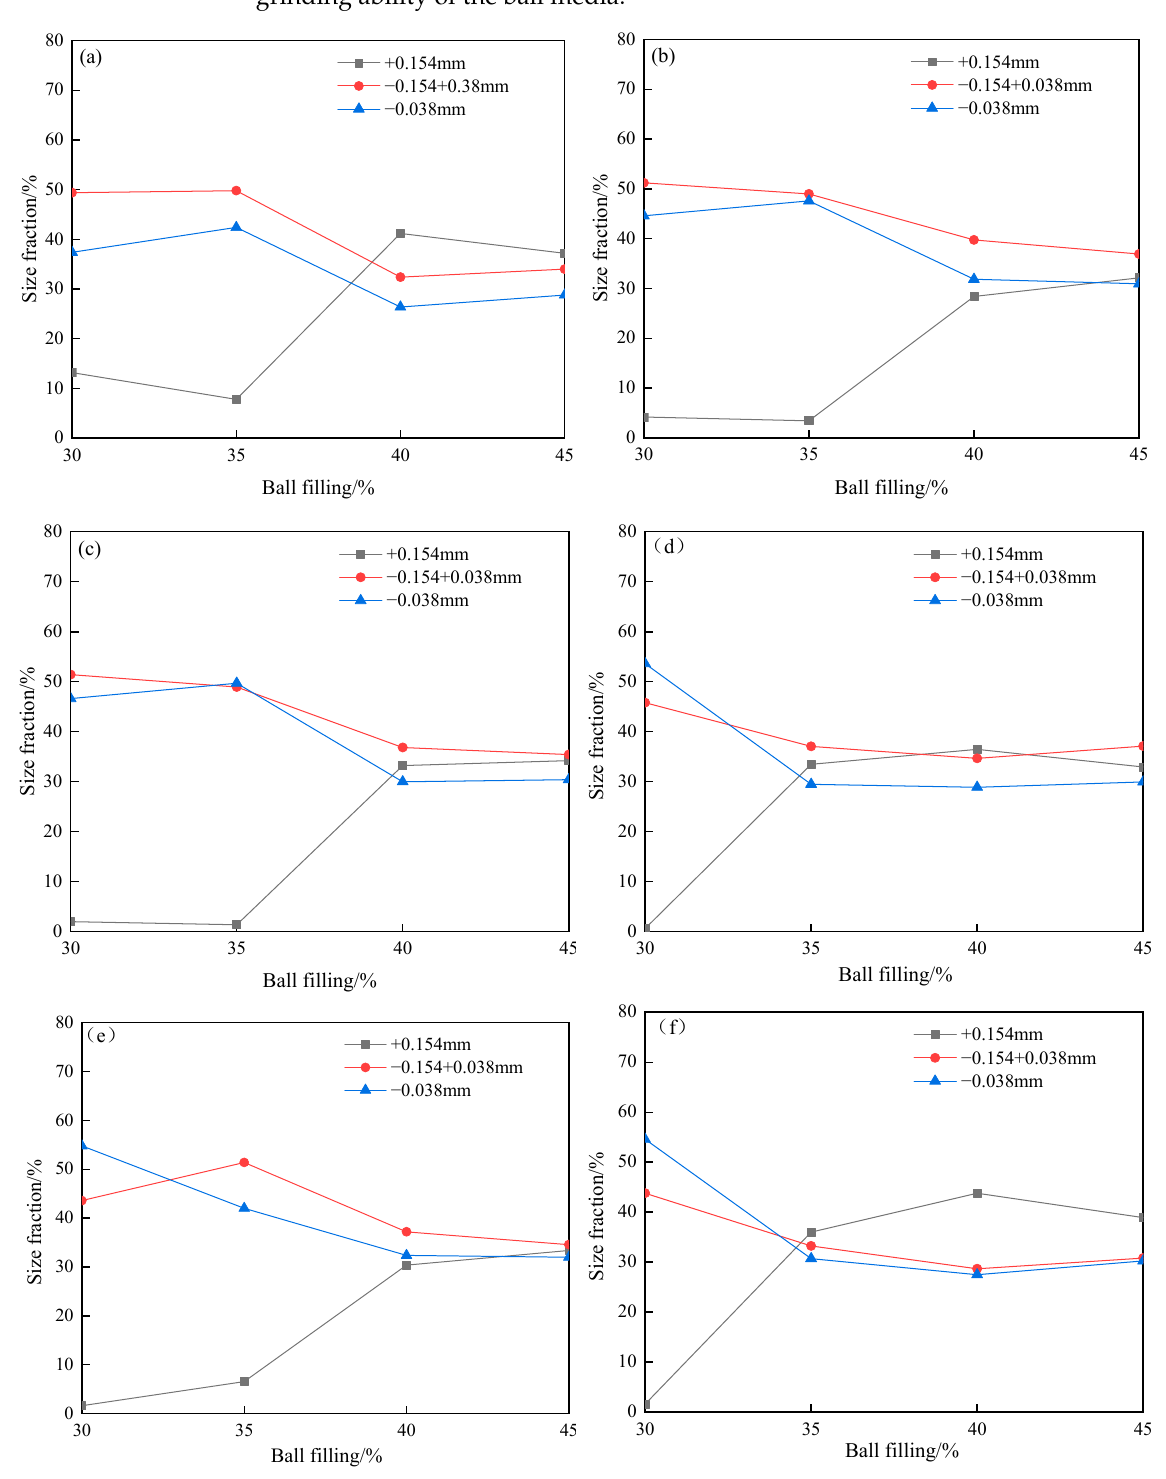
Figure 3. Plot of the yields of the size fractions of the grinding product against the ball filling fraction for balls that were ( a ) 40, ( b ) 30, ( c ) 25, ( d ) 20, ( e ) 18, and ( f ) 16 mm in diameter. Figure 3 indicates that for each size of the ball medium, the effect of the grinding ball’s size on the grinding results is closely related to the ball charge filling volume frac- tion. This total trend reflects the decrease in the grinding ability of the ball medium with